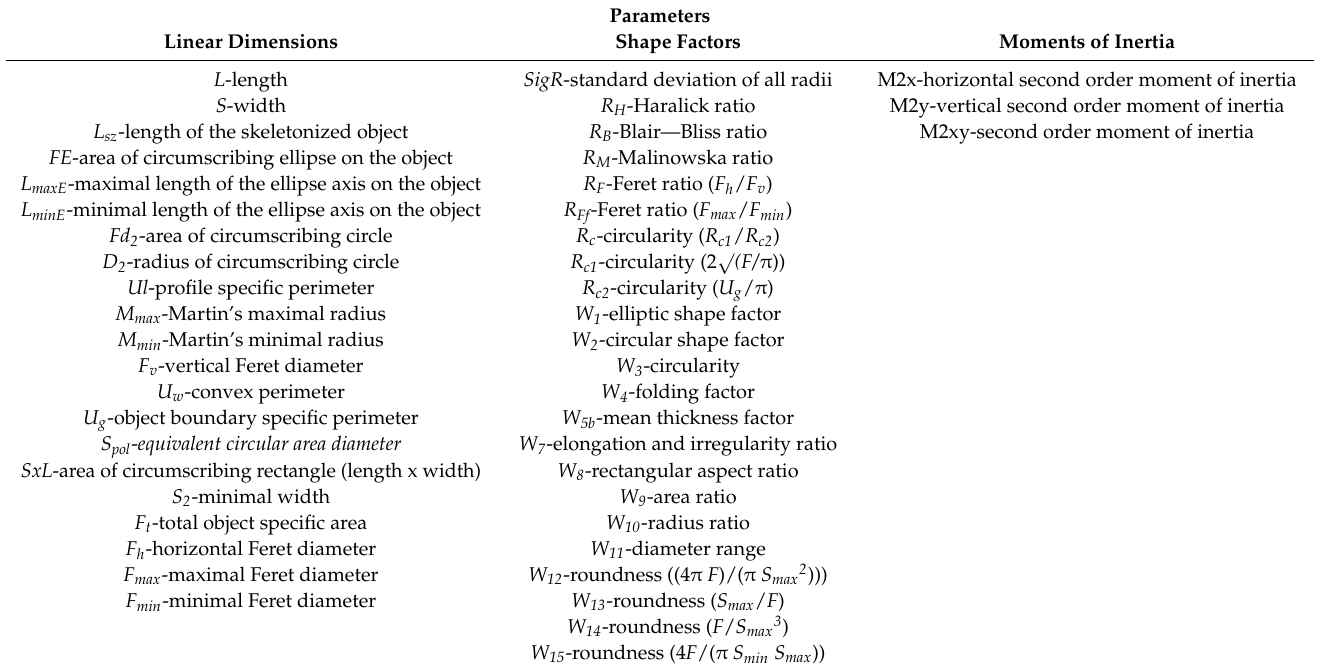
Table 1. The geometric parameters including linear dimensions, shape factors, and moments of